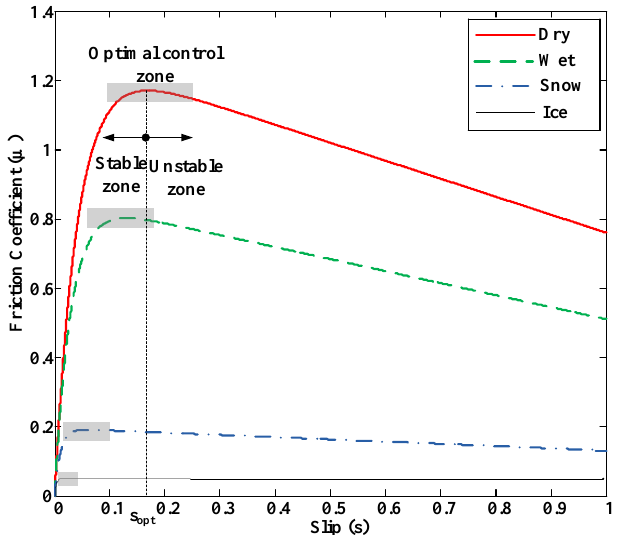
Figure 1. Adhesion curves for different surfaces with optimal control areas.